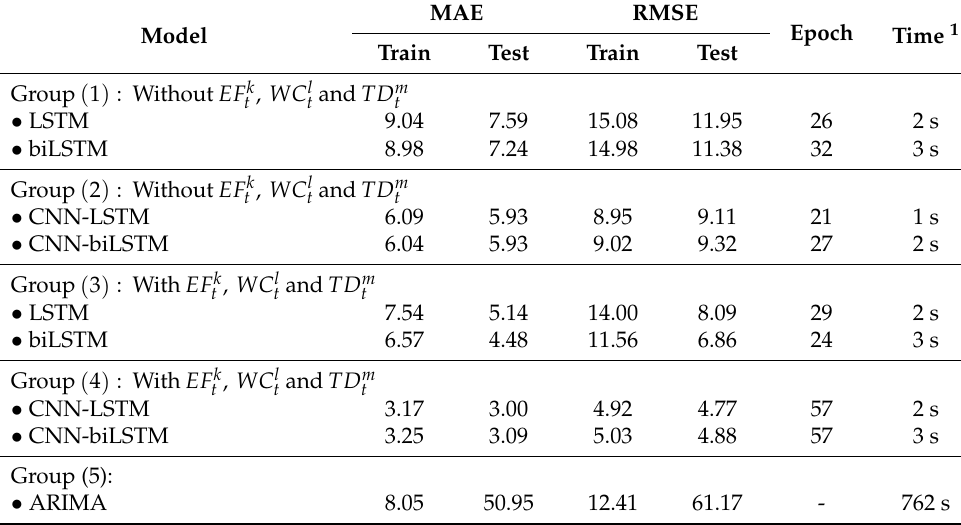
Table 1. Predictive performance comparison.